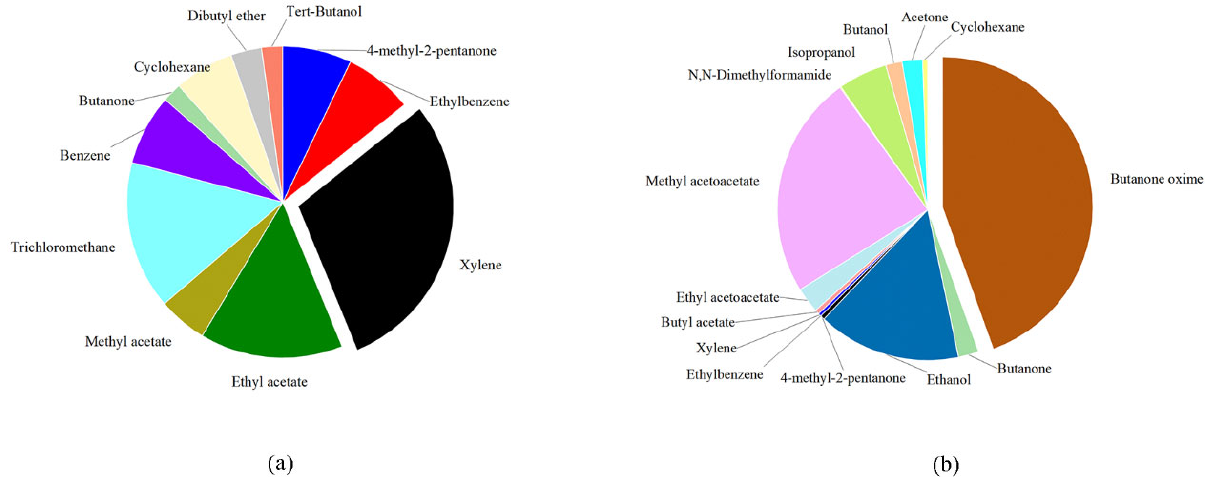
Figure 3. Contributions to cumulative average concentrations of the compounds emitted from white emulsion adhesives ( a ) and silicone adhesives ( b ).